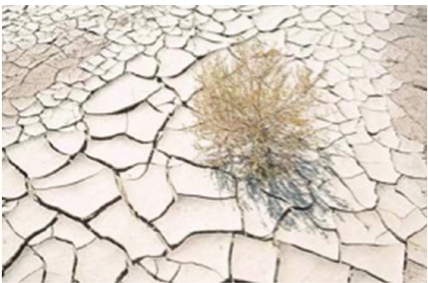
F 3: Graphic representation of BrM degradation (crack forma- tion) and subsequent growth of bloodvessels through the